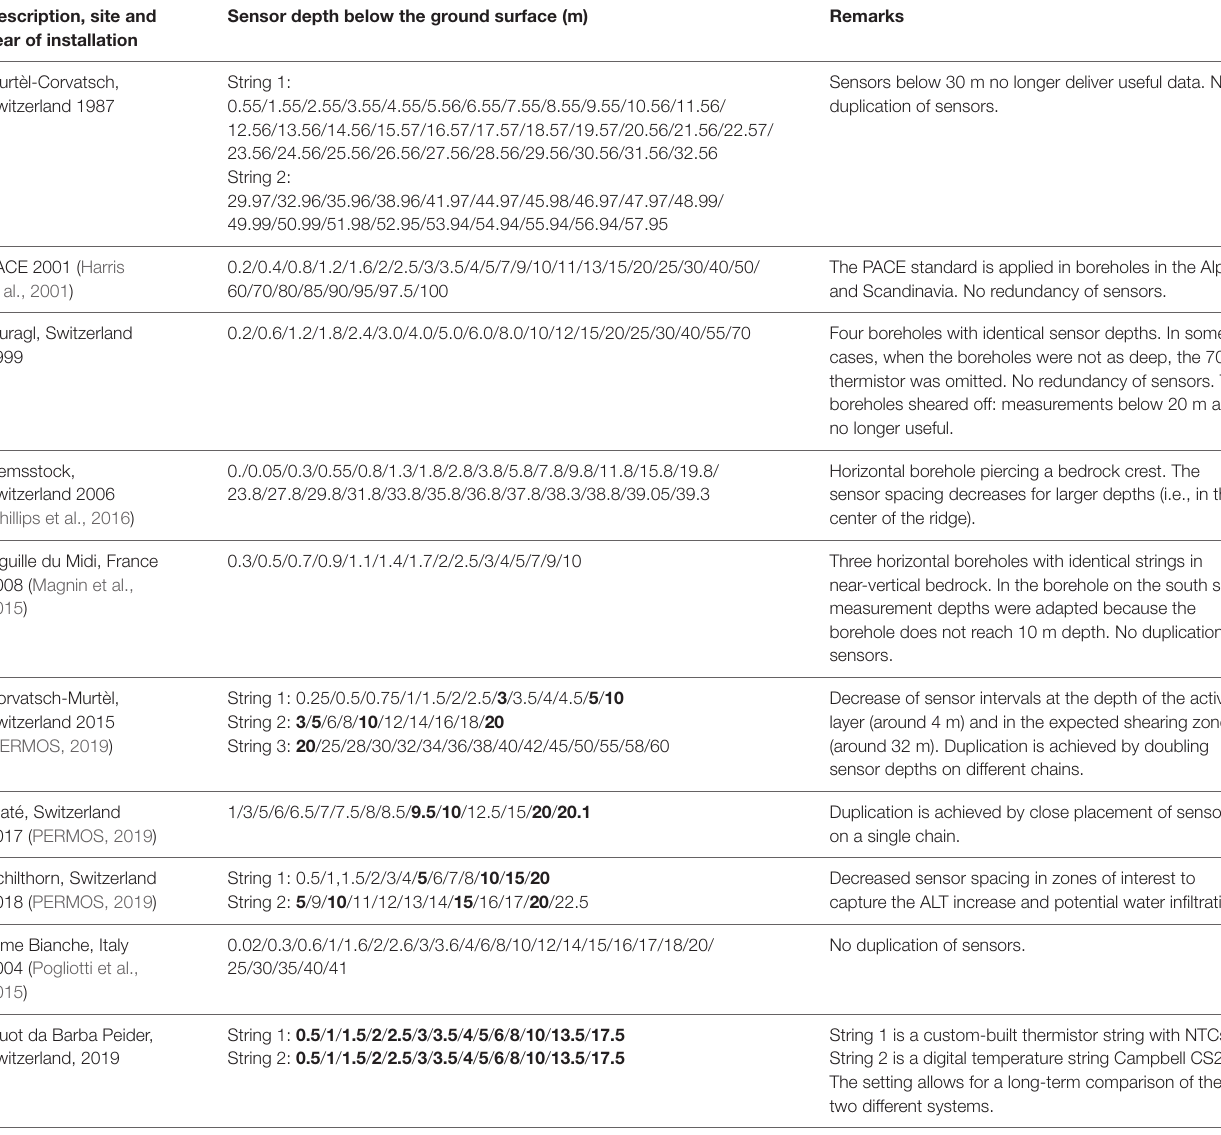
TABLE 1 | Temperature sensor spacing defined within the PACE Project in 2001 as well as for recently instrumented boreholes in the Alps. Description, site and Sensor depth below the ground surface year of installation